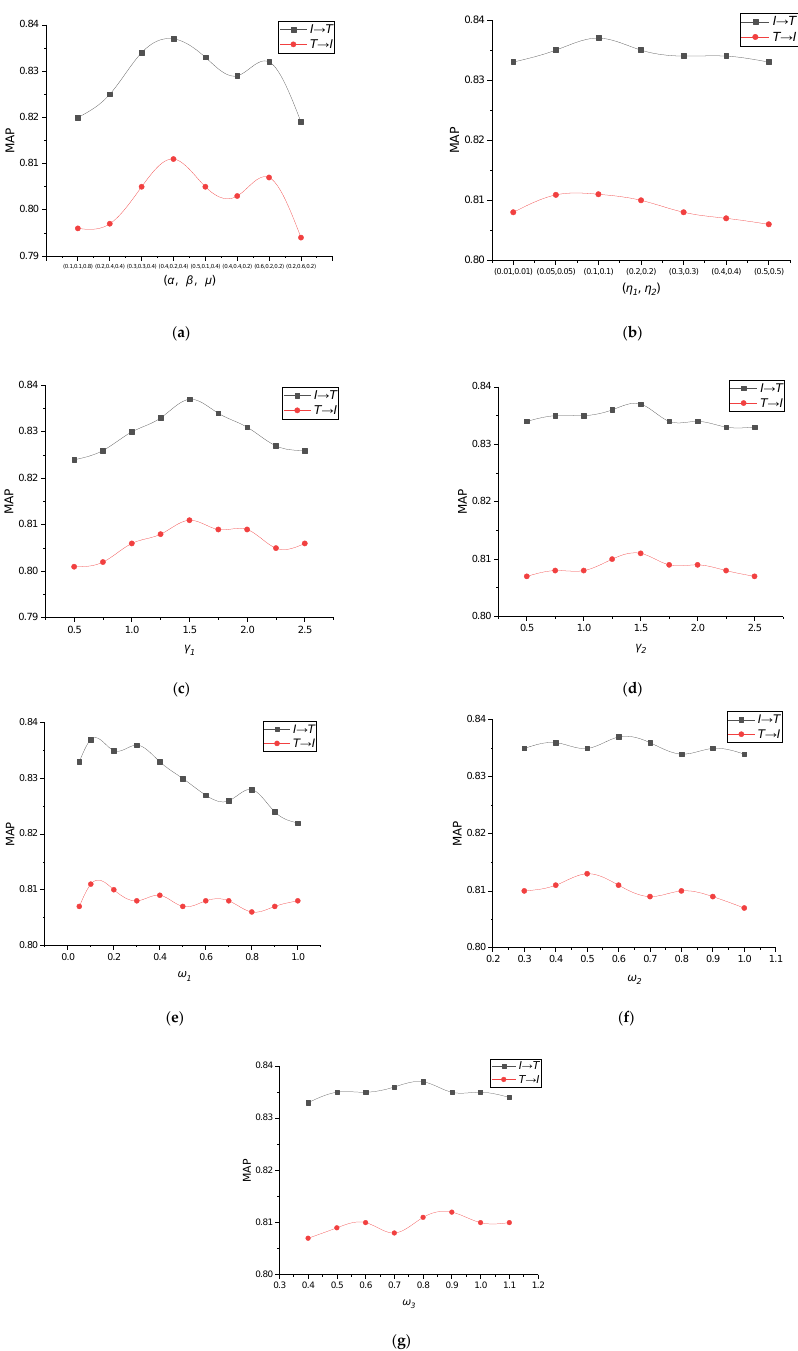
Figure 6. The mAP value of the proposed method’s cross-modal retrieval performances with different parameter values on the NUS-WIDE dataset. ( a ) The cross-modal retrieval performances with different α , β , μ values and the best performance is obtained when α = 0.4, β = 0.2, μ = 0.4. ( b ) The cross-modal retrieval performances with different η 1 and η 2 values and the best performance is obtained when η 1 = 0.1, η 2 = 0.1. ( c ) The cross-modal retrieval performances with different γ 1 values and the best performance is obtained when γ 1 = 1.5. ( d ) The cross-modal retrieval performances with different γ 2 values and the best performance is obtained when γ 2 = 1.5. ( e ) The cross-modal retrieval performances with different ω 1 values and the best performance is obtained when ω 1 = 0.1. ( f ) The cross-modal retrieval performances with different ω 2 values and the best performance is obtained when ω 2 = 0.6. ( g ) The cross-modal retrieval performances with different ω 3 values and the best performance is obtained when ω 3 = 0.8.